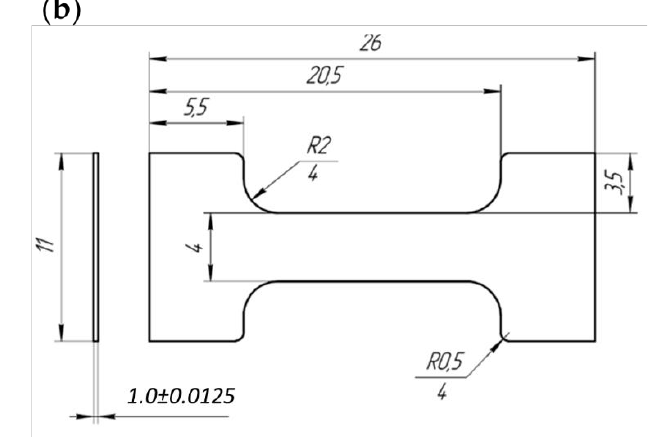
Figure 4. Appearance of 3D-printed specimens ( left ) and principal layout of experimental setup for in situ SEM study of mechanical response ( right ).